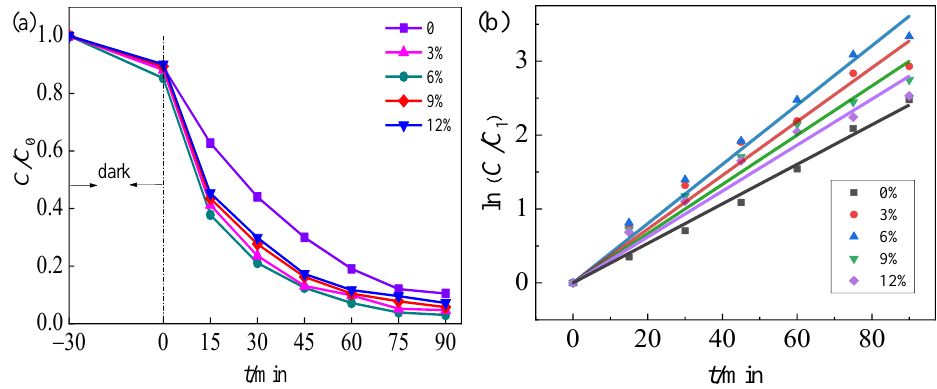
Figure 1. Degradation results of methyl orange by TiO 2 -RGO with different GO contents ( a ) and its first-order kinetic analysis ( b ). C 0 is the initial concentration, C 1 is the concentration at 0 min.